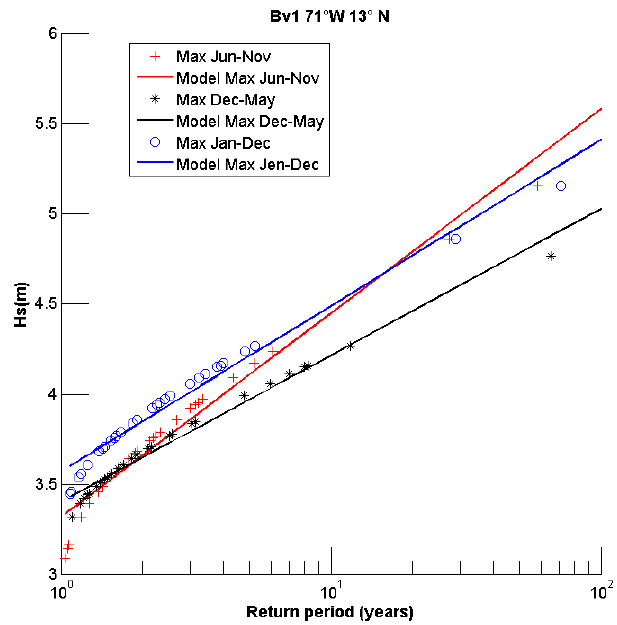
Figure 6. Comparison of the extreme wave regime in virtual buoy 09, considering the maximums of the complete series, the maxi- mums of the cold front season, and the maximums of the hurricane